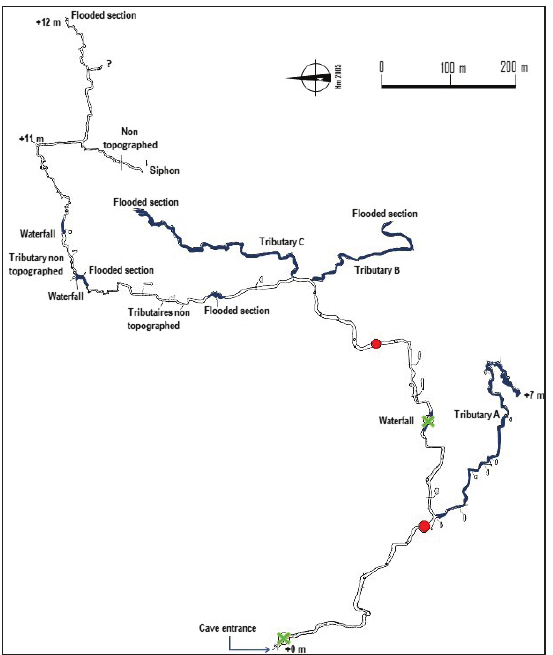
Figure 2. Cave topography. Red points: Sampling localities (green crosses included), green crosses: P. subtruncatum occurence.